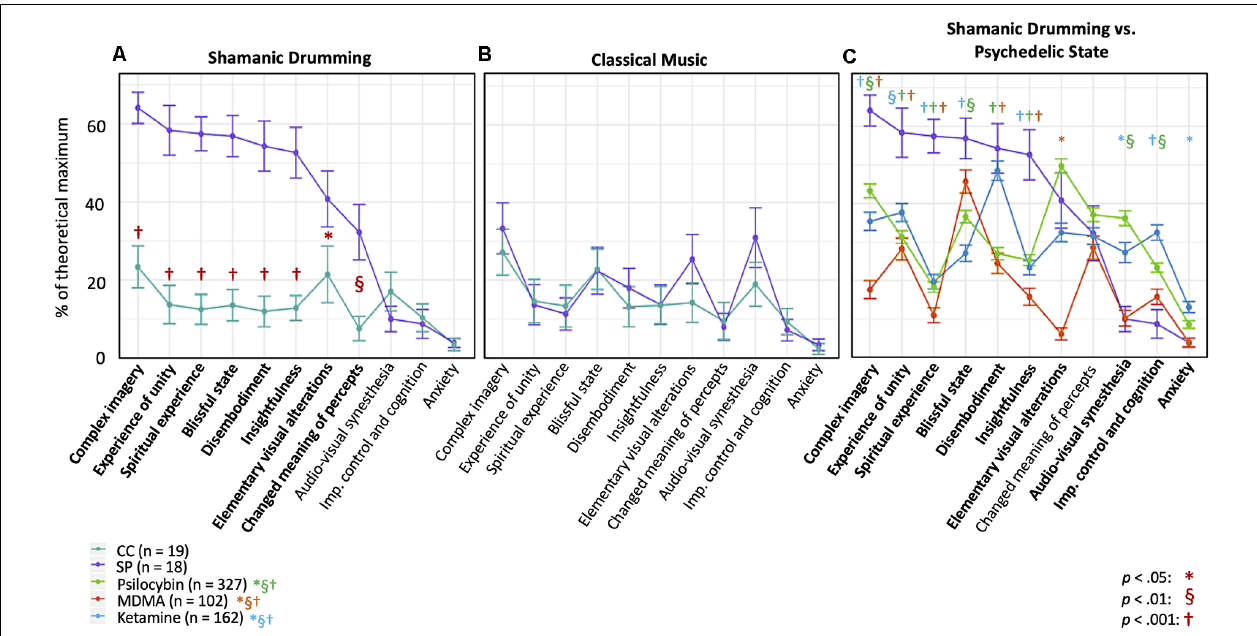
FIGURE 2 | Shamanic practitioners enter an altered state of consciousness during shamanic drumming. (A) Shamanic Practitioners (SP, purple, n = 18) were significantly different from control participants (CC, green, n = 19) during drumming in 8 of the 11 OAV domains. Each point represents the mean of all SP or CC for the percent of the theoretical scale maximum for that domain. Error bars represent the standard error of the mean. (B) SP did not differ from CC during classical music listening on any of the domains. (C) We replotted the OAV mean and standard error for healthy controls taking psilocybin (green, n = 327), ketamine (blue, n = 162), or MDMA (orange, n = 102) from Studerus et al. (2010) and compared these scores to those acquired from SP. Overall, SP had increased scores in several domains compared to all three drug conditions, as well as similar scores in the remaining domains compared to various drug conditions.